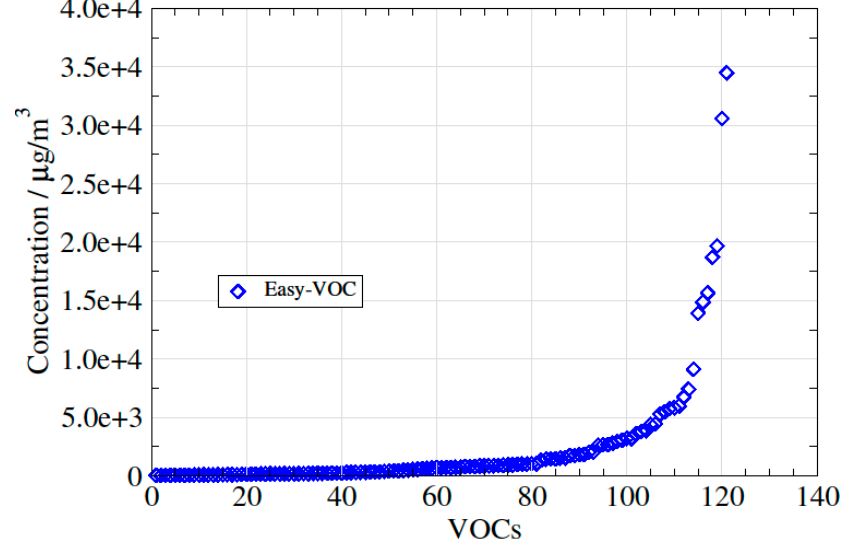
Figure 4. Variation in concentration for the 130 VOCs measured in this study.